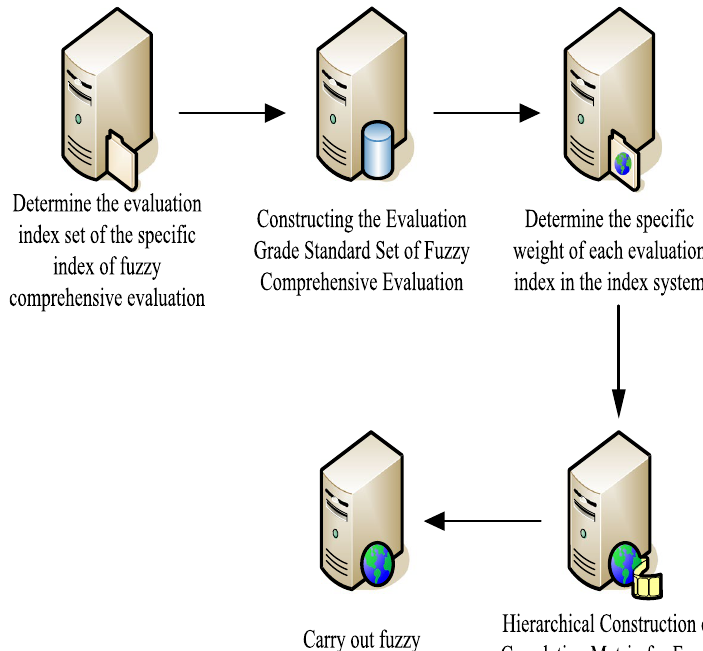
Fig. 4 Operation process of fuzzy comprehensive evaluation